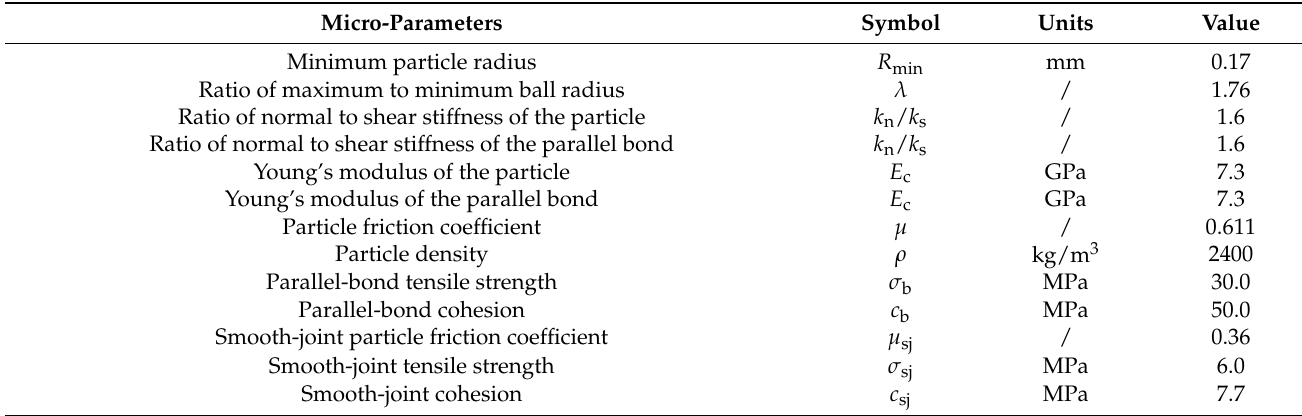
Table 1. Micro-parameters of the numerical model.